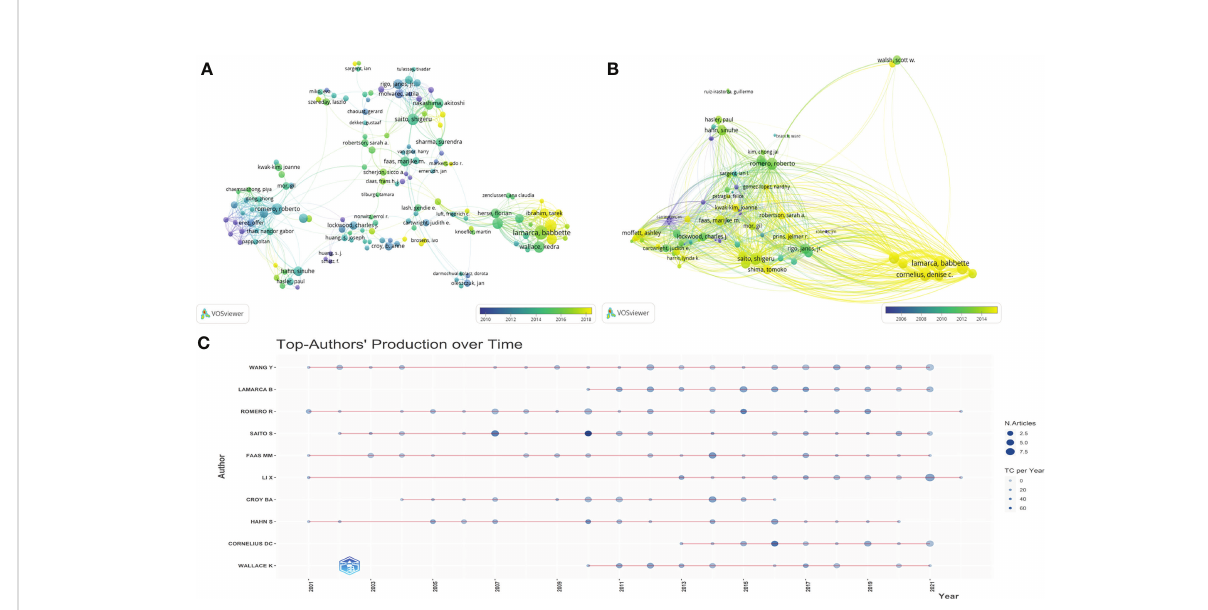
FIGURE 5 Authorship and co-authorship and citation analysis in the fi eld of HDP and immune cells. (A) Network visualization of author co-authorship. (B) Network visualization of co-authorship citation counts. (C) Top-Author ’ Producation over time.